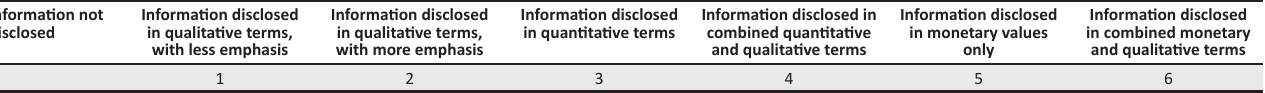
TABLE 1: The seven-point intellectual capital disclosure measurement